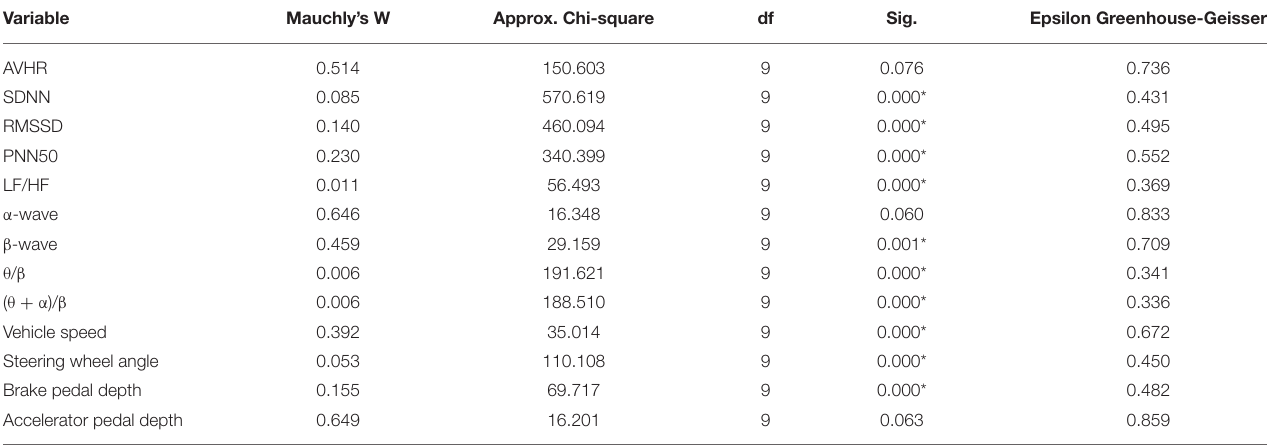
TABLE 3 | Mauchly’s test of sphericity of HRV, EEG, and vehicle behavior indicators. Variable Mauchly’s